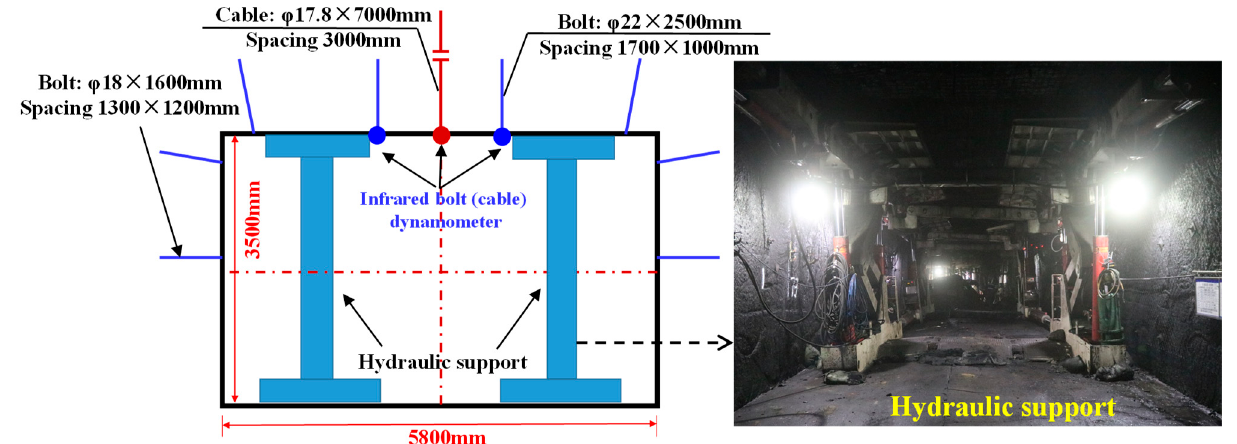
Figure 2. Roadway support parameter .